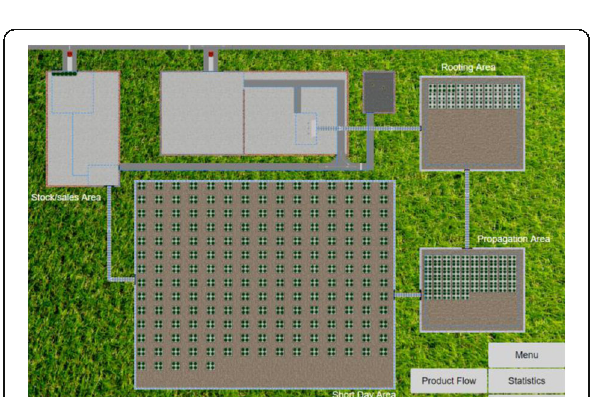
Fig. 3 (Abstract P9). Greenhouse production flow simulation